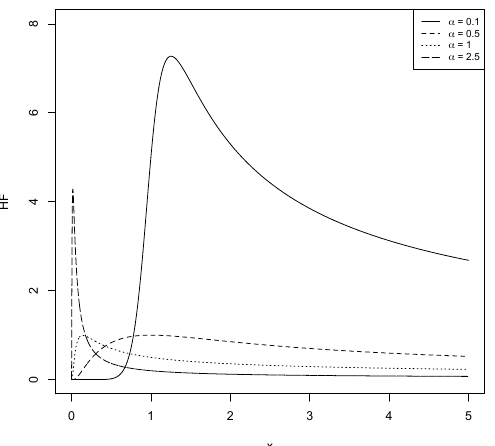
Figure 3. The HF for the LBS distribution with different values for α and β = 1.